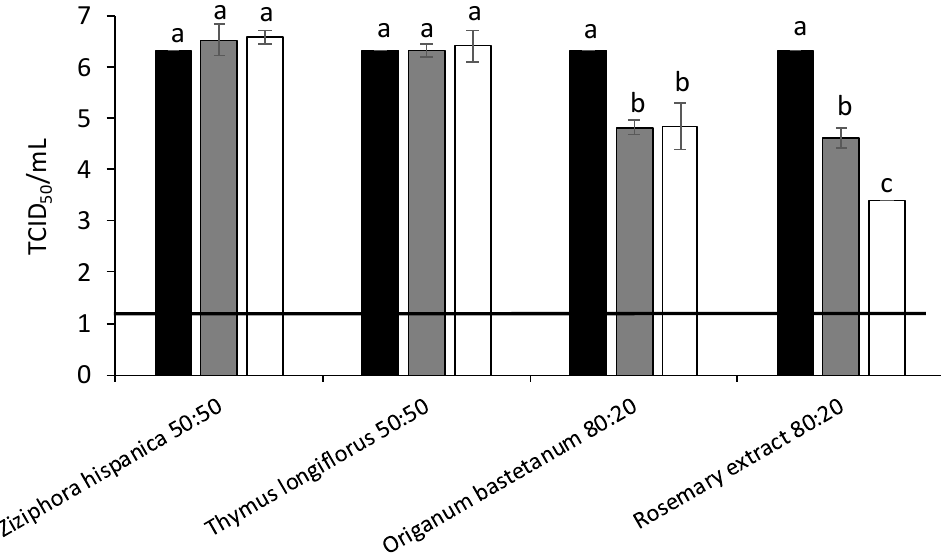
Figure 3. Reduction of murine norovirus (MNV) titers (log TCID50/mL) treated with different extracts after 37 ◦ C/ON incubations. Black bars: Control; Grey bars: 0.5 mg/mL; White bars: 5 mg/mL. Each bar represents the average of triplicates. Within each column, different letters denote significant differences between treatments. Horizontal line depicts the detection limit.